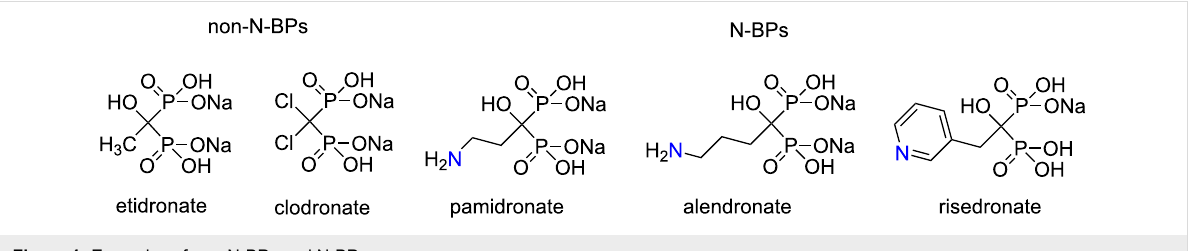
Figure 1: Examples of non-N-BPs and